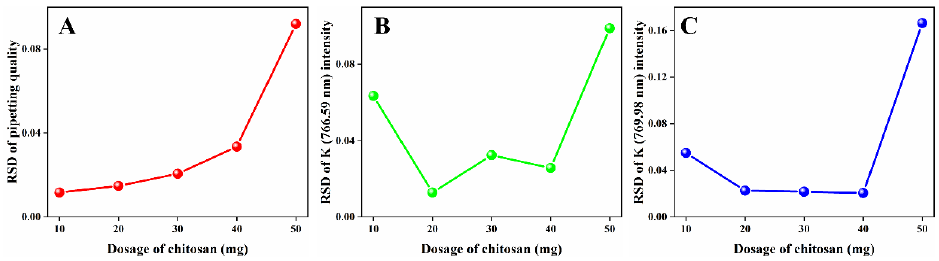
Figure 5. RSD of ( A ) pipetting quality, ( B ) K (766.59 nm) intensity and ( C ) K (769.98 nm) intensity based on different dosages of chitosan dissolved in 5 mL of glacial acetic acid solution